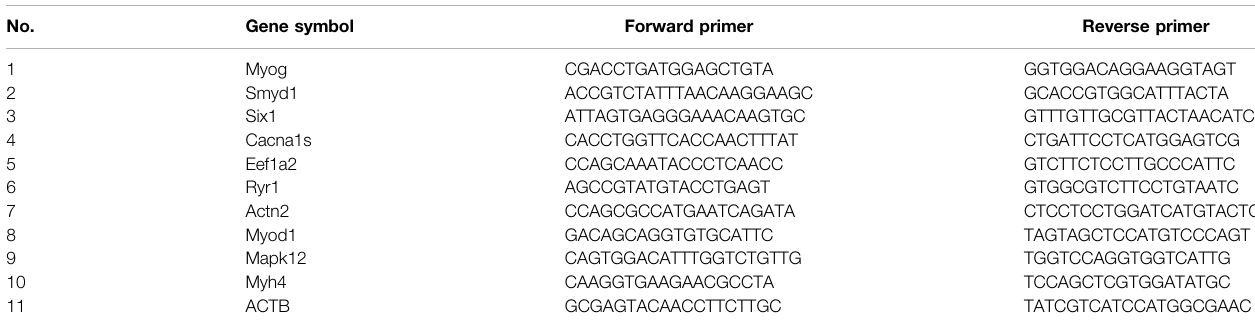
TABLE 2 | Primer sequences used for real-time